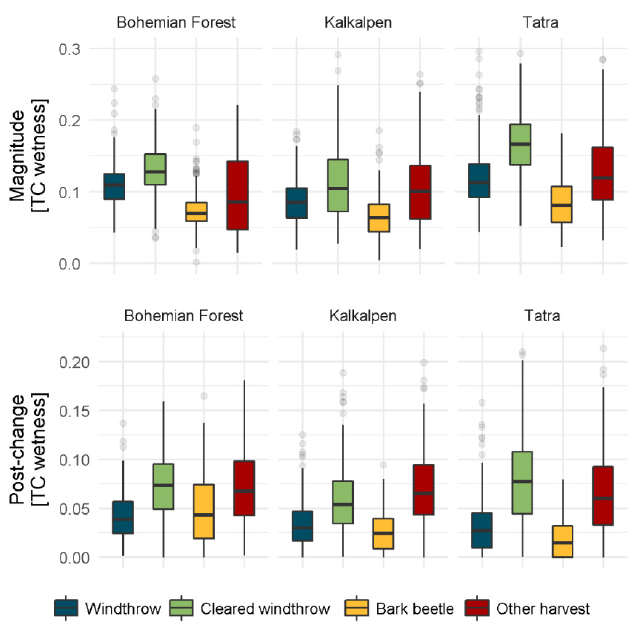
Figure 7. Distributions of disturbance magnitude and post-disturbance change for disturbance agent classes based on visually interpreted agent polygons. TC = Tasseled Cap.